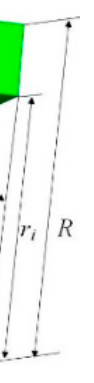
Figure 7. The subdivision unit.